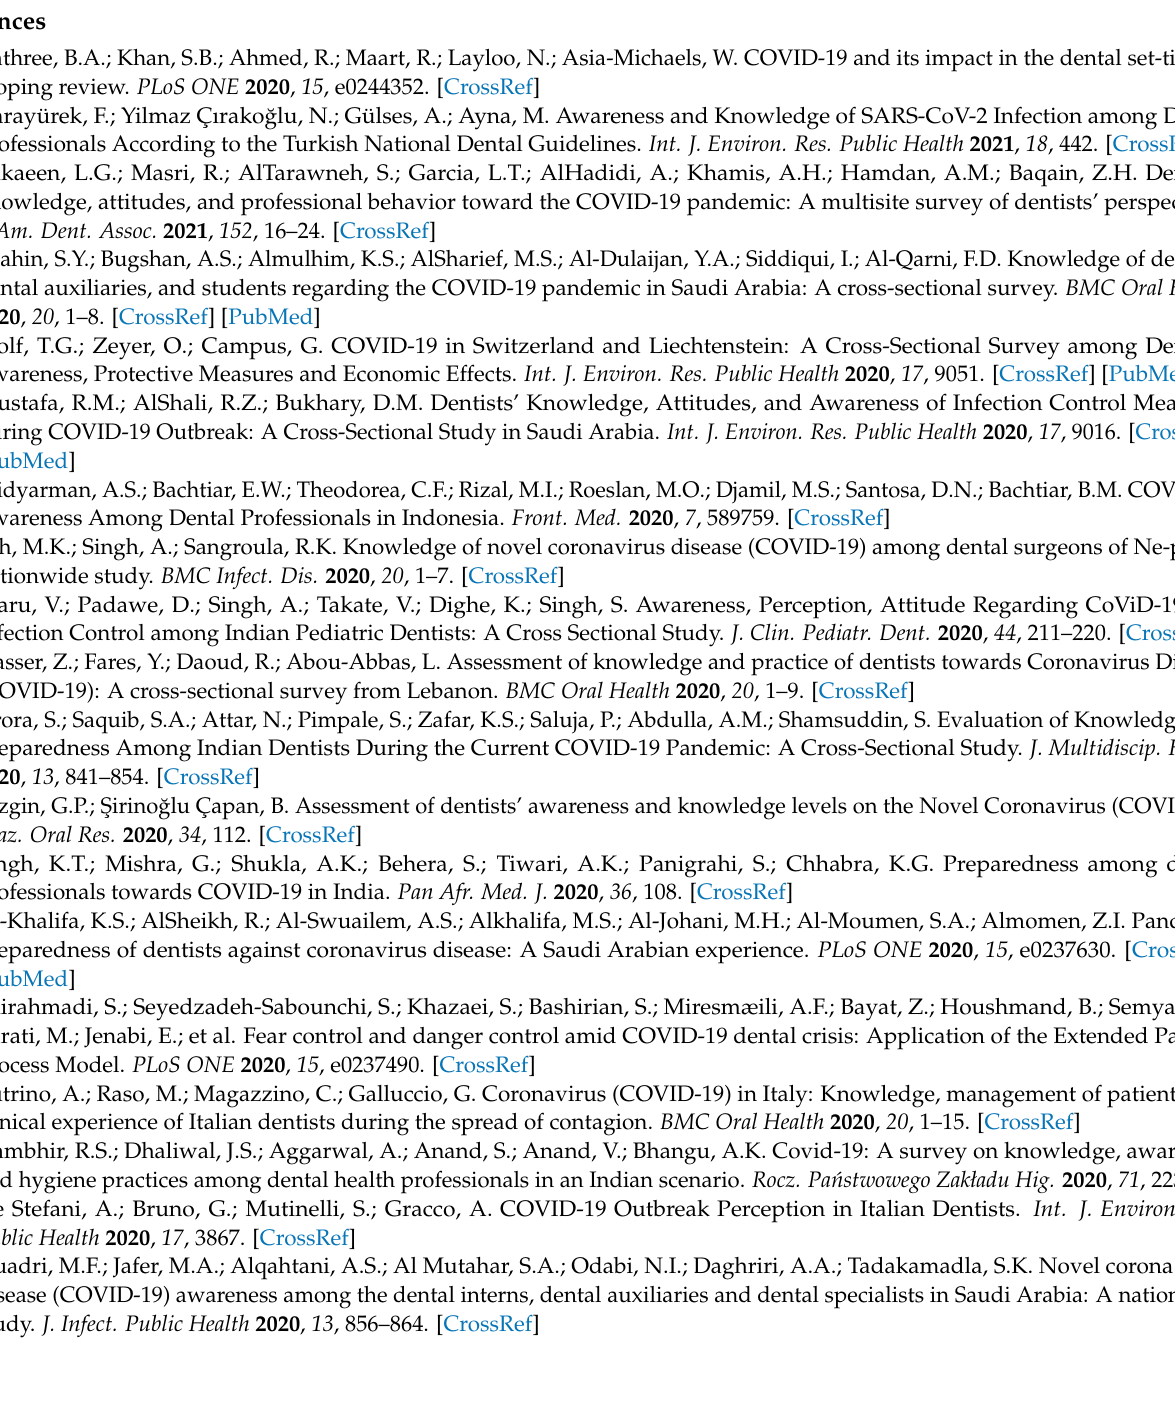
2 (Table 1: Appointments and patients) • 3 D1: “We also write this in the patient file /, that they had no contact with Corona-patients /, whether they were affected themselves /, that you look right at